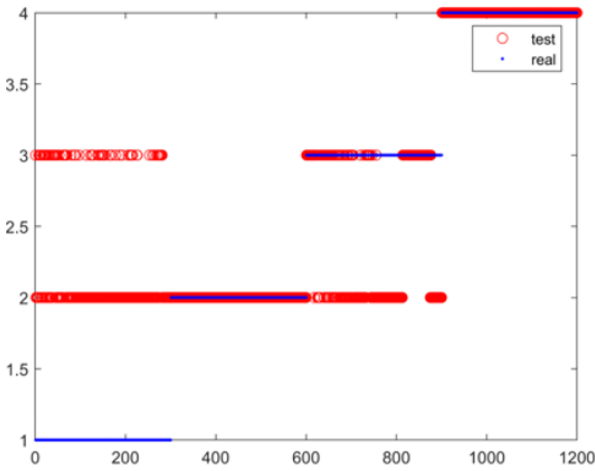
Figure 12. Classification results of the feature